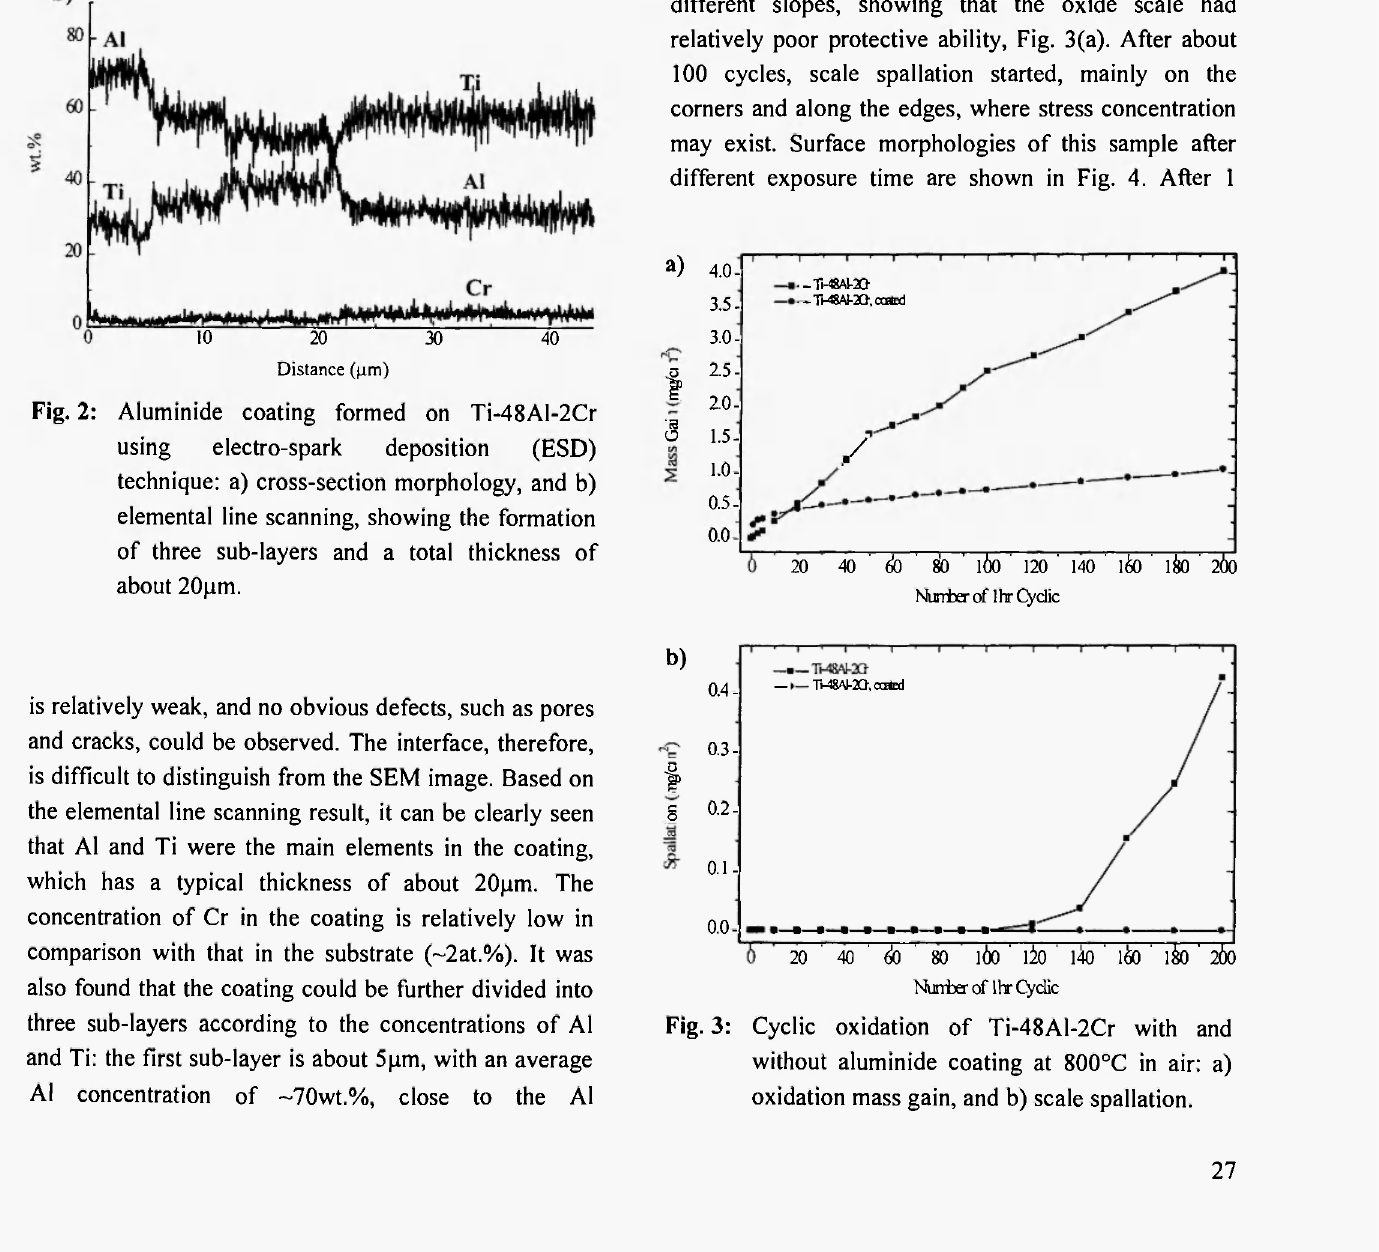
Fig. 3: Cyclic oxidation of Ti-48Al-2Cr with and without aluminide coating at 800°C in air: a) oxidation mass gain, and b) scale